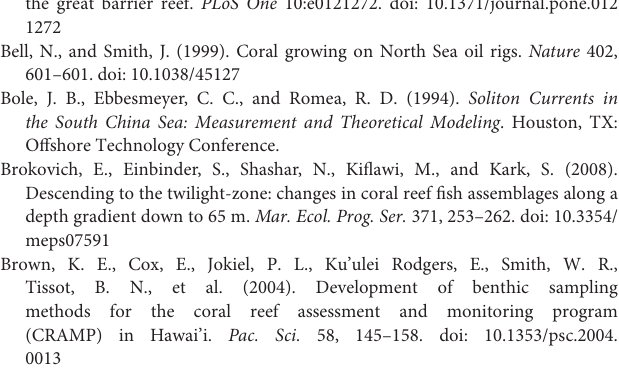
TABLE S1 | Transect lengths and replicate numbers (in parentheses) according to year and depth for surveys of invertebrates and fishes associated with GWA platform. Replicates for invertebrates refer to quadrats examined along the length of a transect, while replicates for fishes refer to the number of transects completed. Frames examined from 125 m during 2008 were obtained from stationary footage obtained 3 months prior to footage for other depths. Note the different depth strata examined for fishes between 2006 and